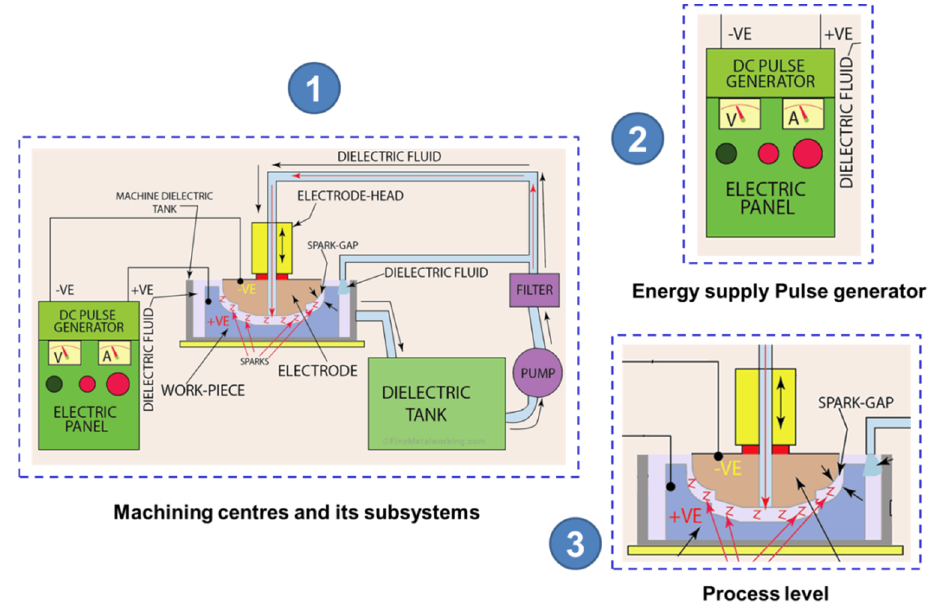
Figure 1. Energy consumption units for WEDM center.